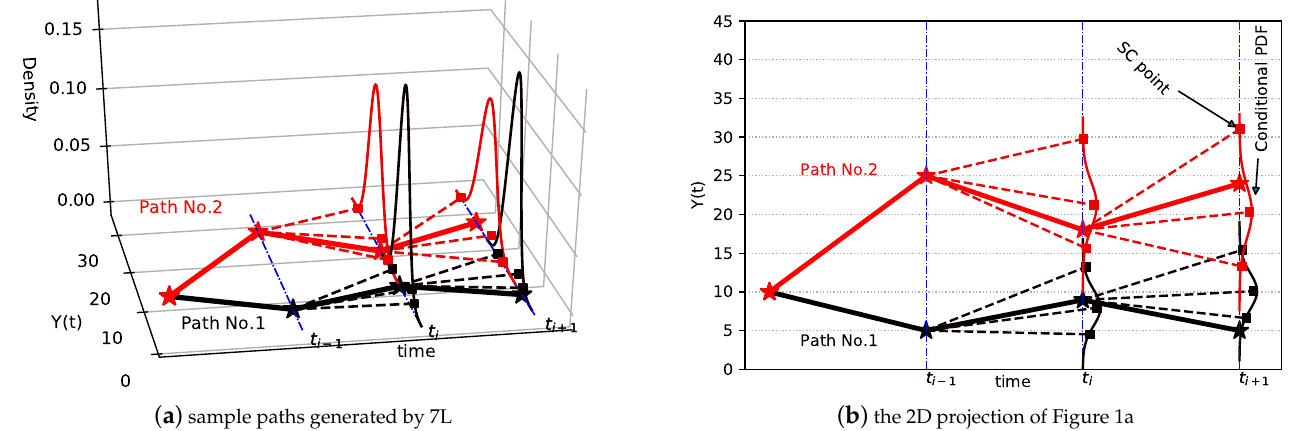
Figure 1. Schematic diagram of the 7L scheme. Here conditional SC points, represented by (cid:4) , are conditional on a previous realization, denoted by (cid:70) . “Conditional PDF” is the conditional probability density function, defined by these conditional SC points. The density function, which is not required by 7L, is plotted only for illustration